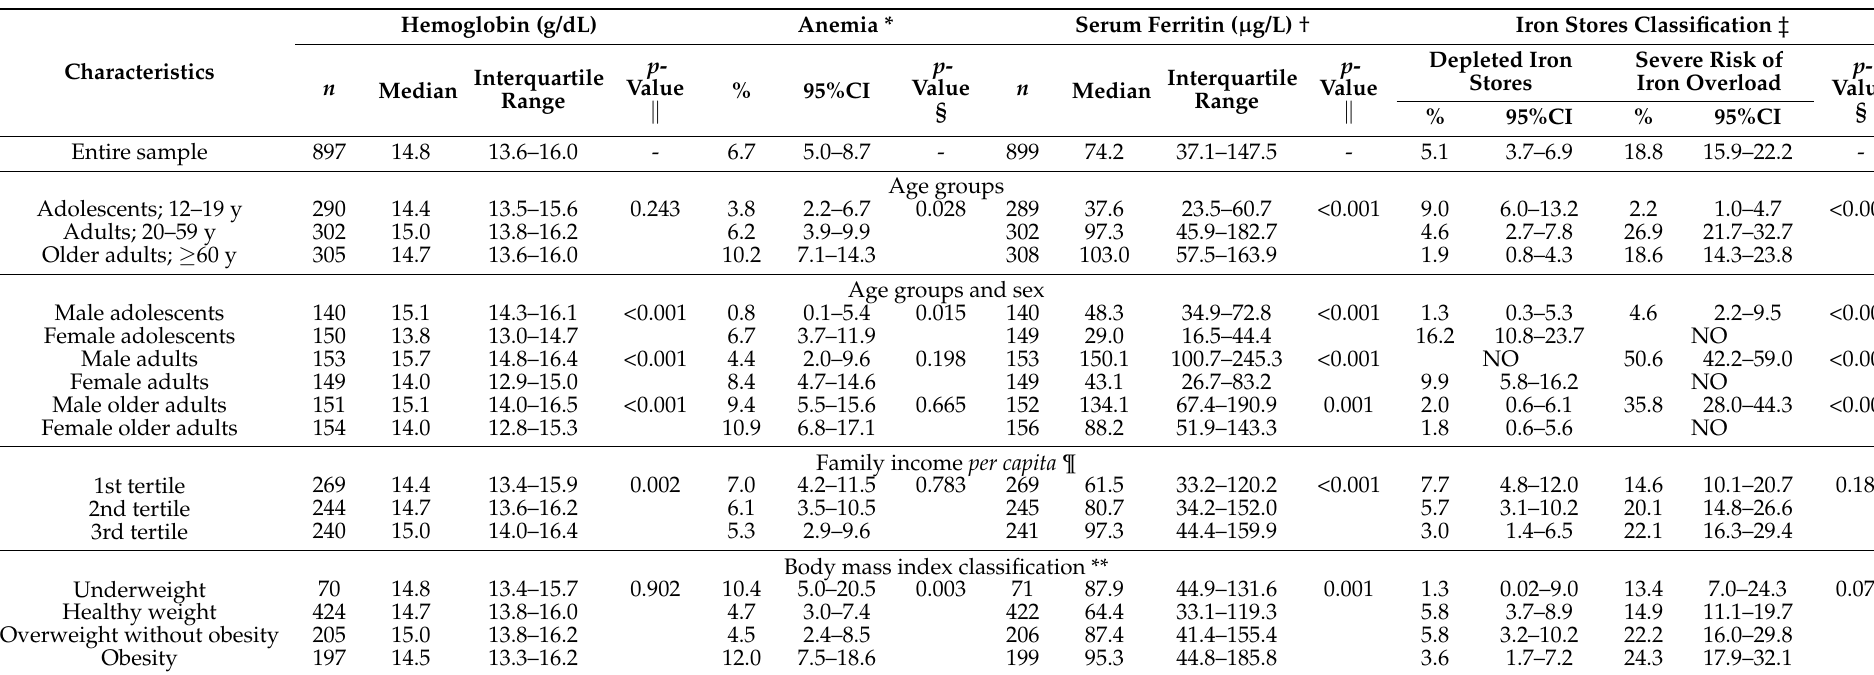
Table 1. Anemia and iron stores among residents of the urban area of S ã o Paulo, according to sociodemographic and lifestyle factors: 2015 Health Survey of S ã o Paulo.